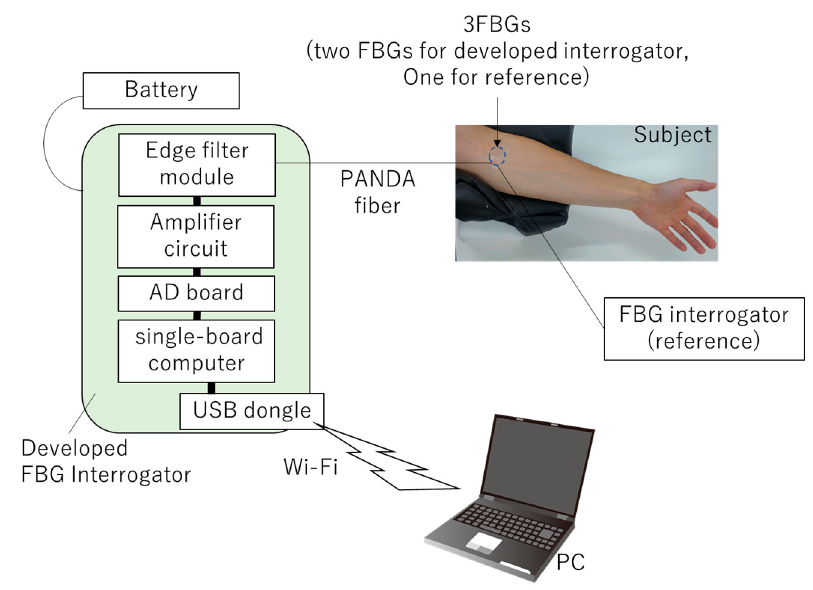
Figure 8. The settings of the plethysmograph measurement. The FBG sensor is taped near the brachial artery. Measured data are saved on a PC, which is connected to the interrogator via Wi-Fi.